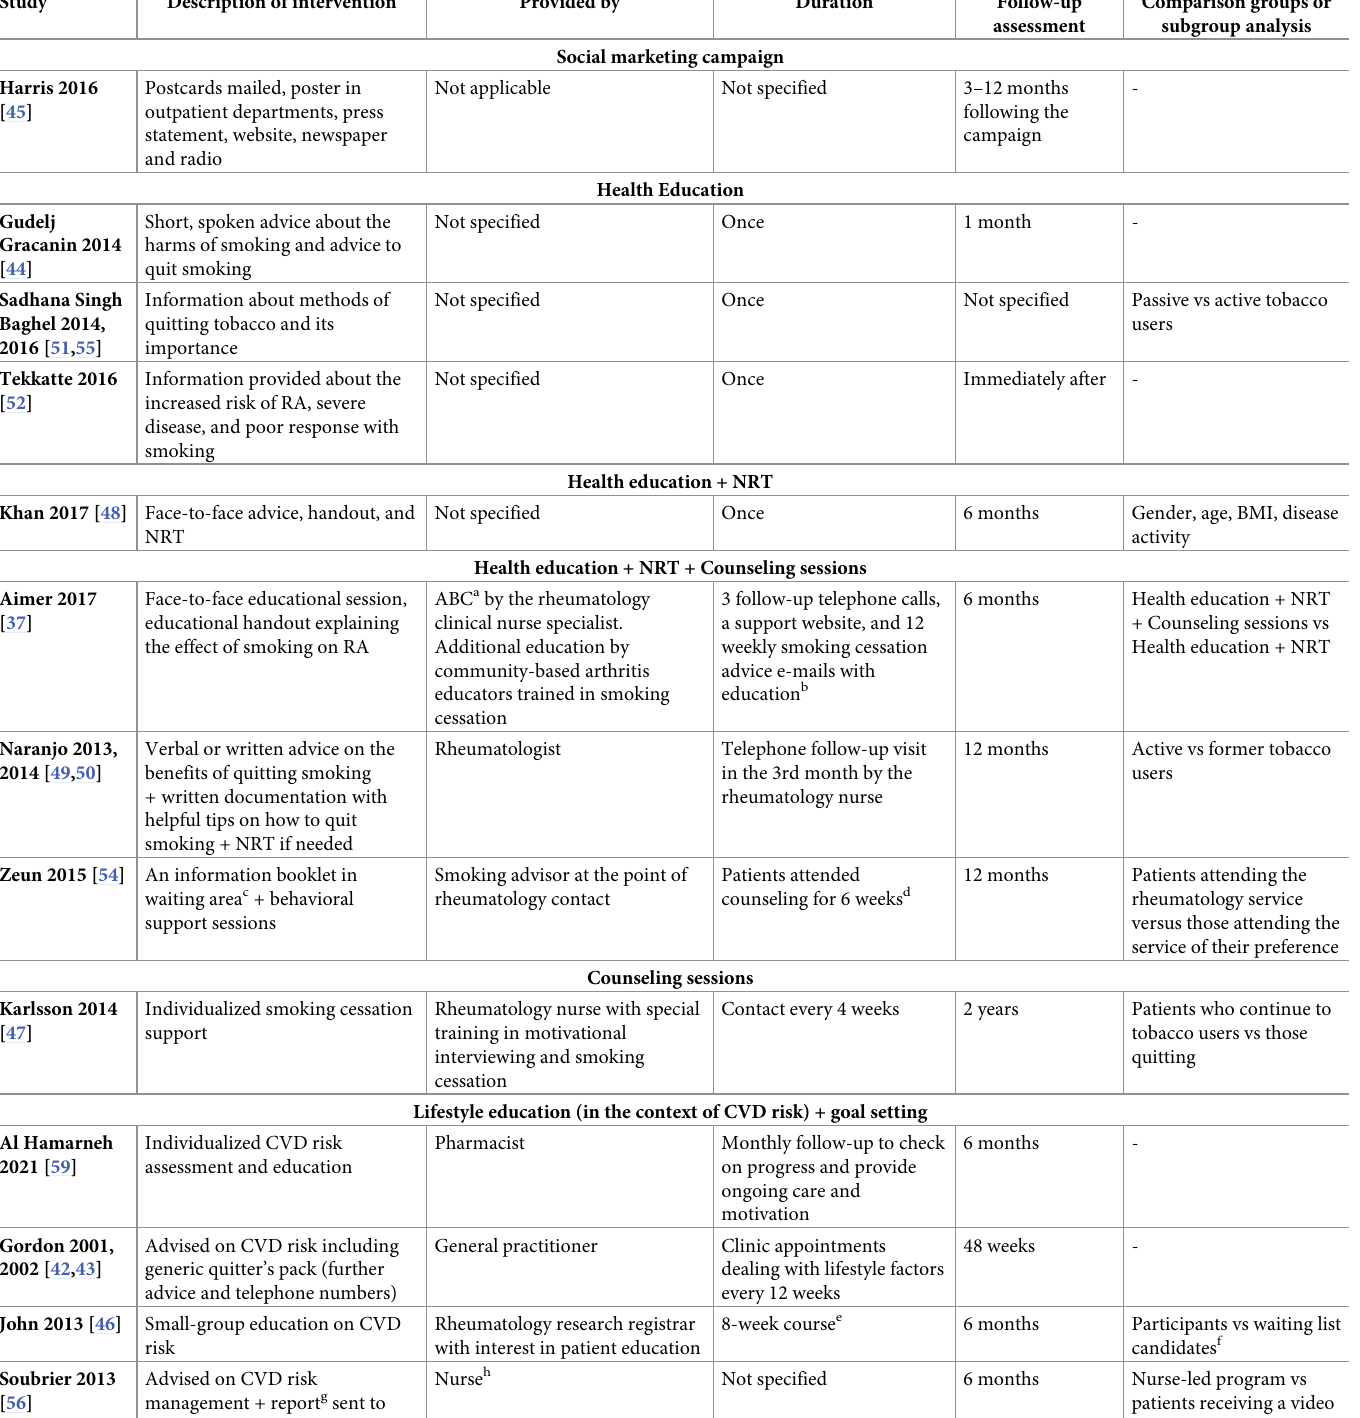
Table 2. Intervention